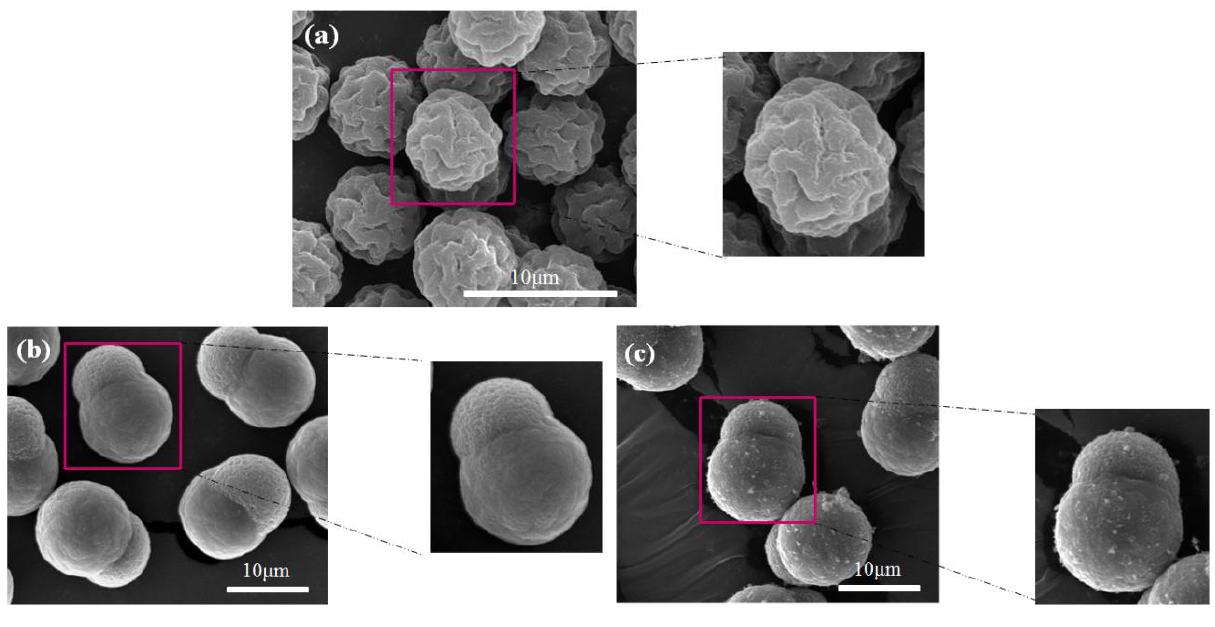
Figure 4. SEM images of ( a ) PMMA seeds; ( b ) pure SL particles; and ( c ) c-MWNT (0.96 wt%) adsorbed SL particles (reprinted with permission from [36], Copyright 2012 The Royal Society of